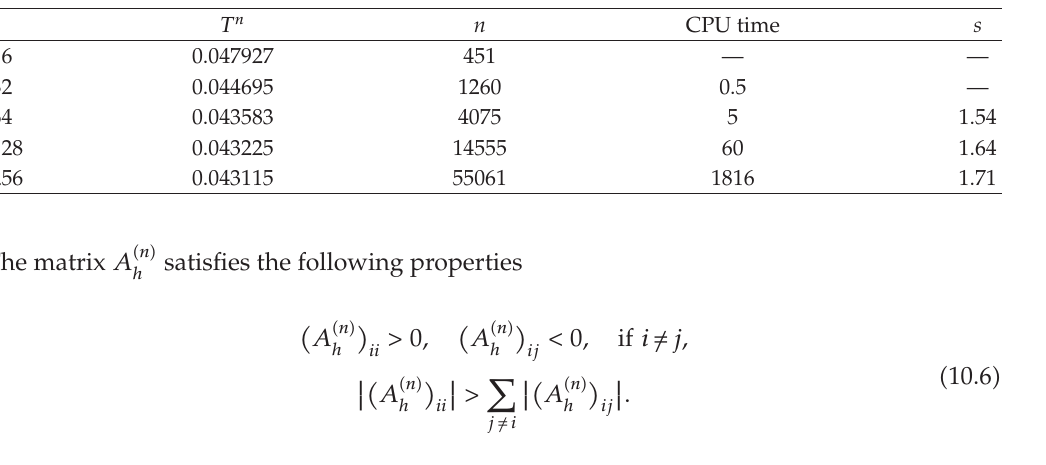
Table 1: Numerical blow-up times, numbers of iterations, CPU times (cid:3) seconds (cid:4) and orders of the approximations obtained with the explicit Euler method defined in (cid:3) 10.1 (cid:4)